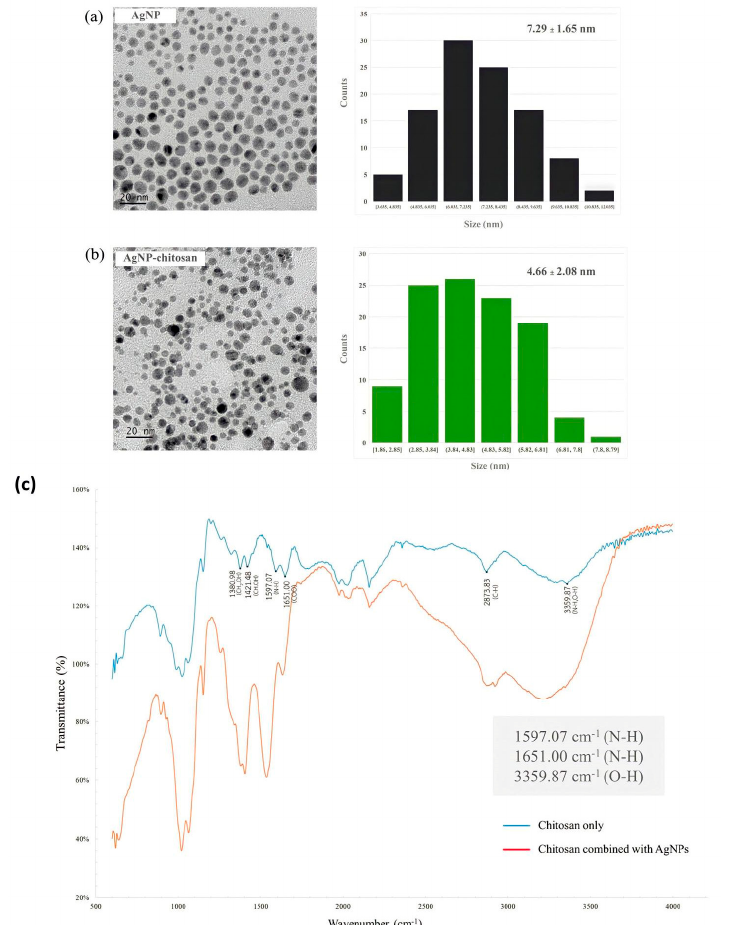
Figure 2. TEM images and average size of silver nanoparticles ( a ) and silver nanoparticle–Chitosan ( b ) corresponding to the photograph sample by Image J program. ( c ) The comparison of FTIR spectra for Chitosan and Chitosan combined with silver nanoparticles.